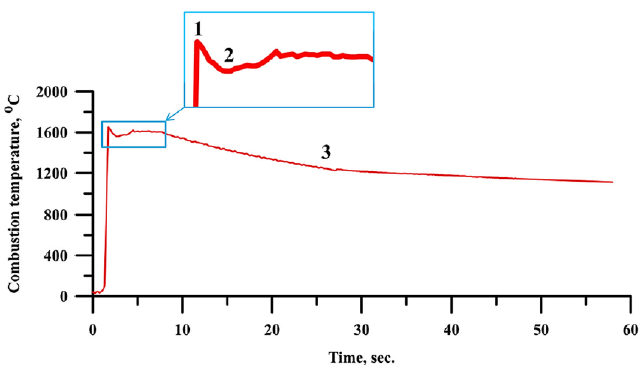
Figure 3. A thermogram of combustion of the samples of the Ti-NiB powder